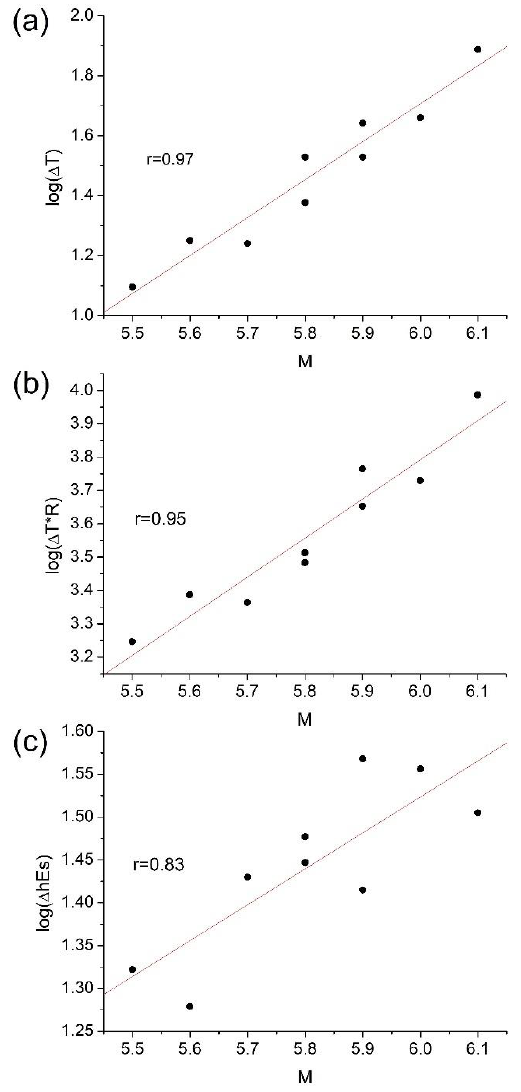
Figure 3. The observed dependencies for ( a ) log ( ∆ T), ( b ) log( ∆ T · R), and ( c ) log( ∆ h ’Es) on the EQ magnitude M, including cases that occurred during disturbed magnetic conditions. Solid lines—linear regressions. Correlation coe ffi cients, r, are also